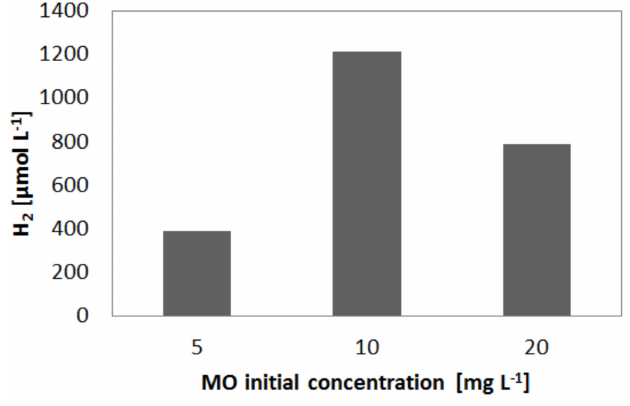
Figure 7. E ff ect of MO initial concentration on H 2 production after 4 h of UV irradiation